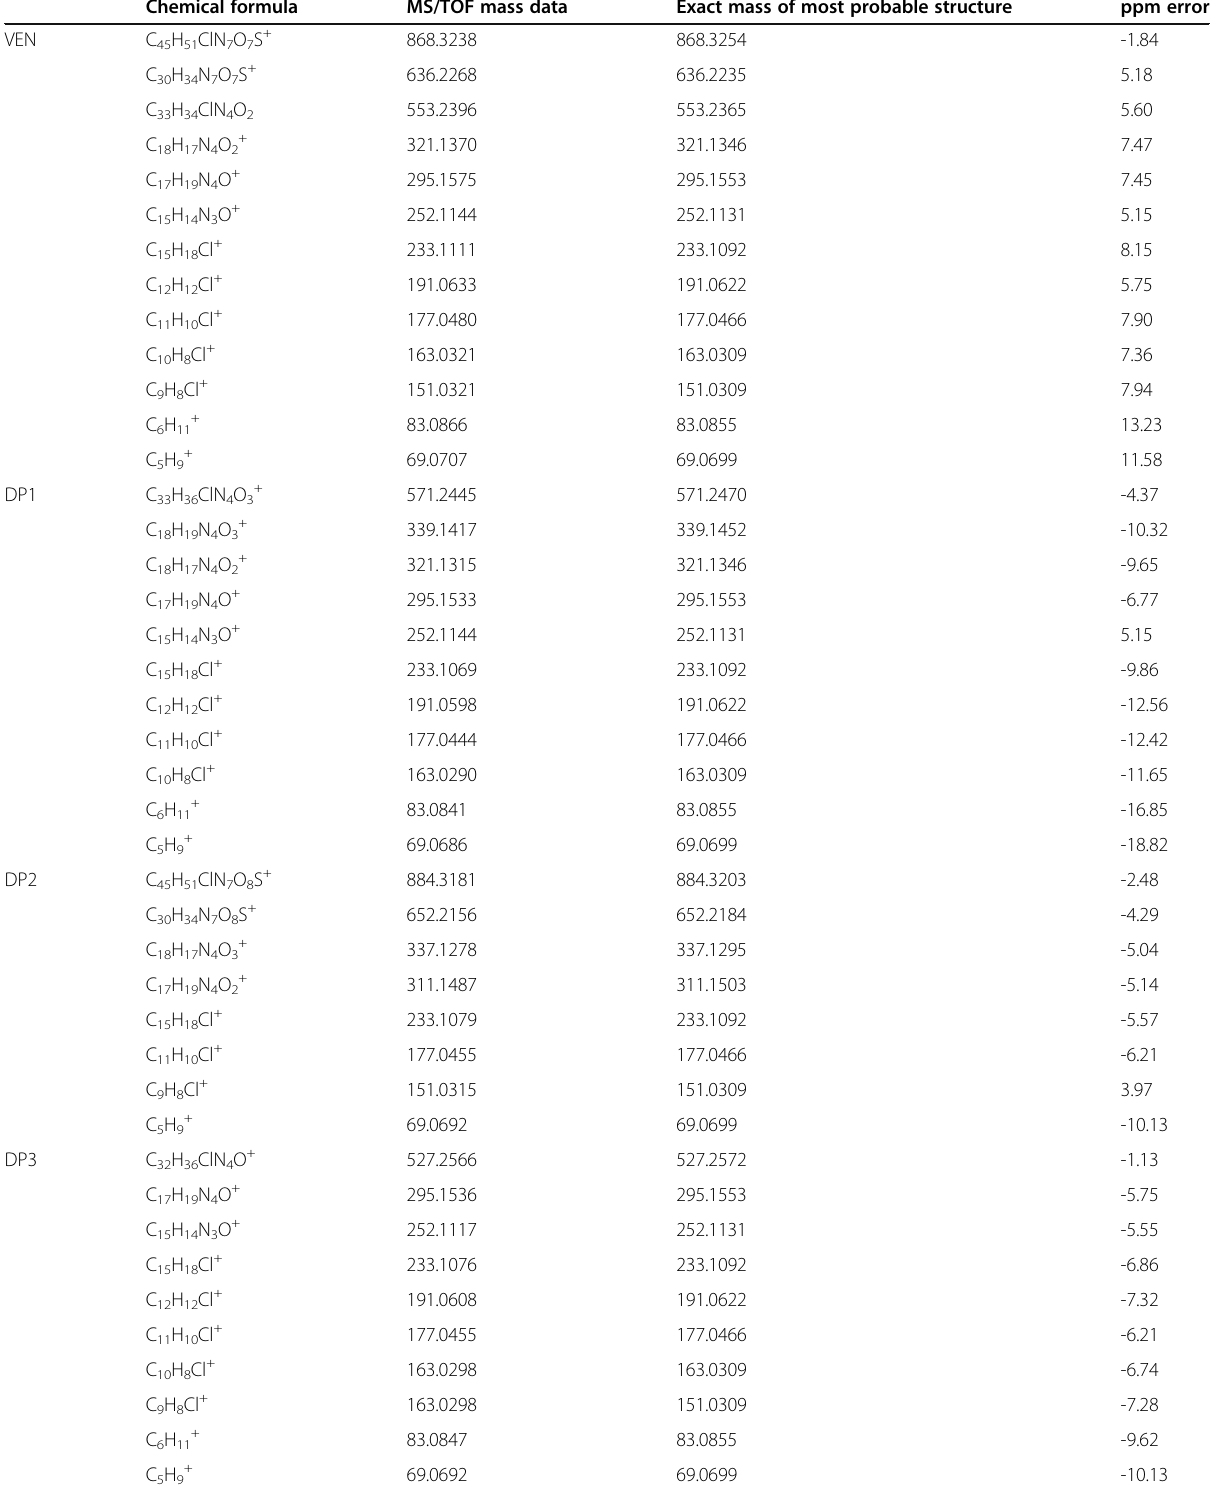
Table 2 HRMS data of product ions of protonated VEN and its degradation